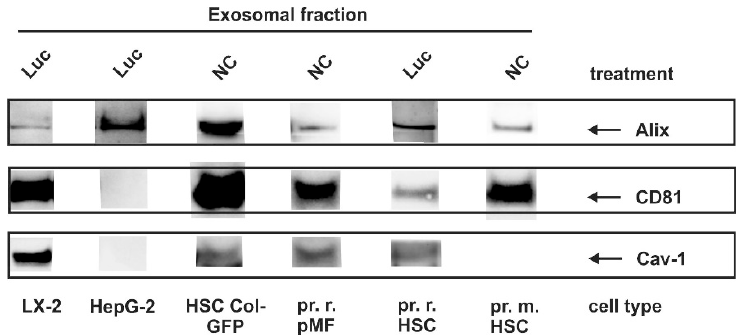
Figure 4. Exosomal marker expression in liver cells. Cells were plated on 10 cm dishes and either cultured in growth medium without further treatment (NC), or subjected to viral infection with a control virus (Luc). Thereafter, exosomes were prepared from the supernatants and marker expression was analyzed by Western blot using antibodies directed against Alg2-interacting protein (Alix), CD81 and Caveolin-1 (Cav-1). Table 2. Exosomal markers identified in liver cells.